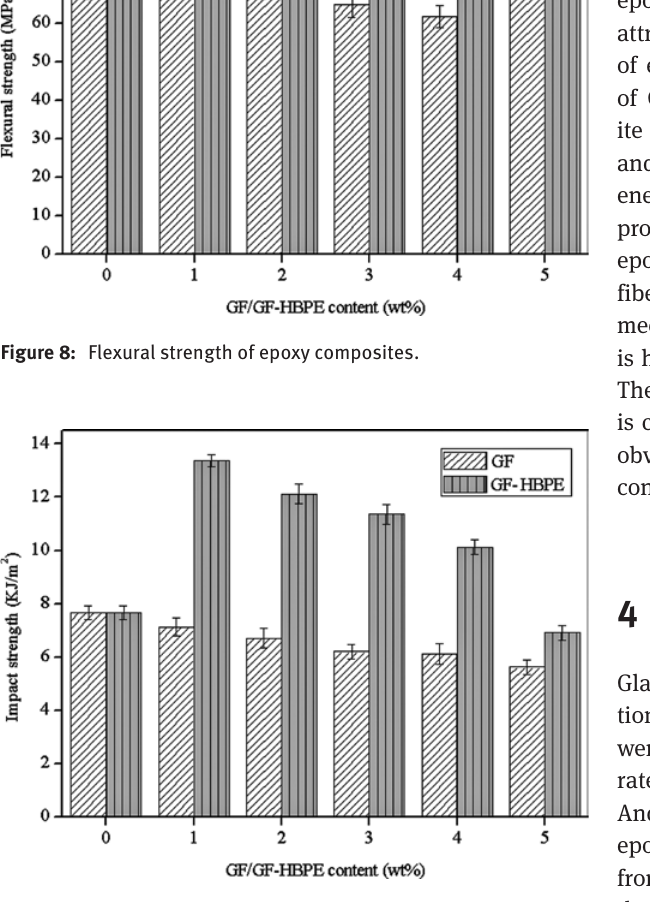
Figure 9: Impact strength of epoxy